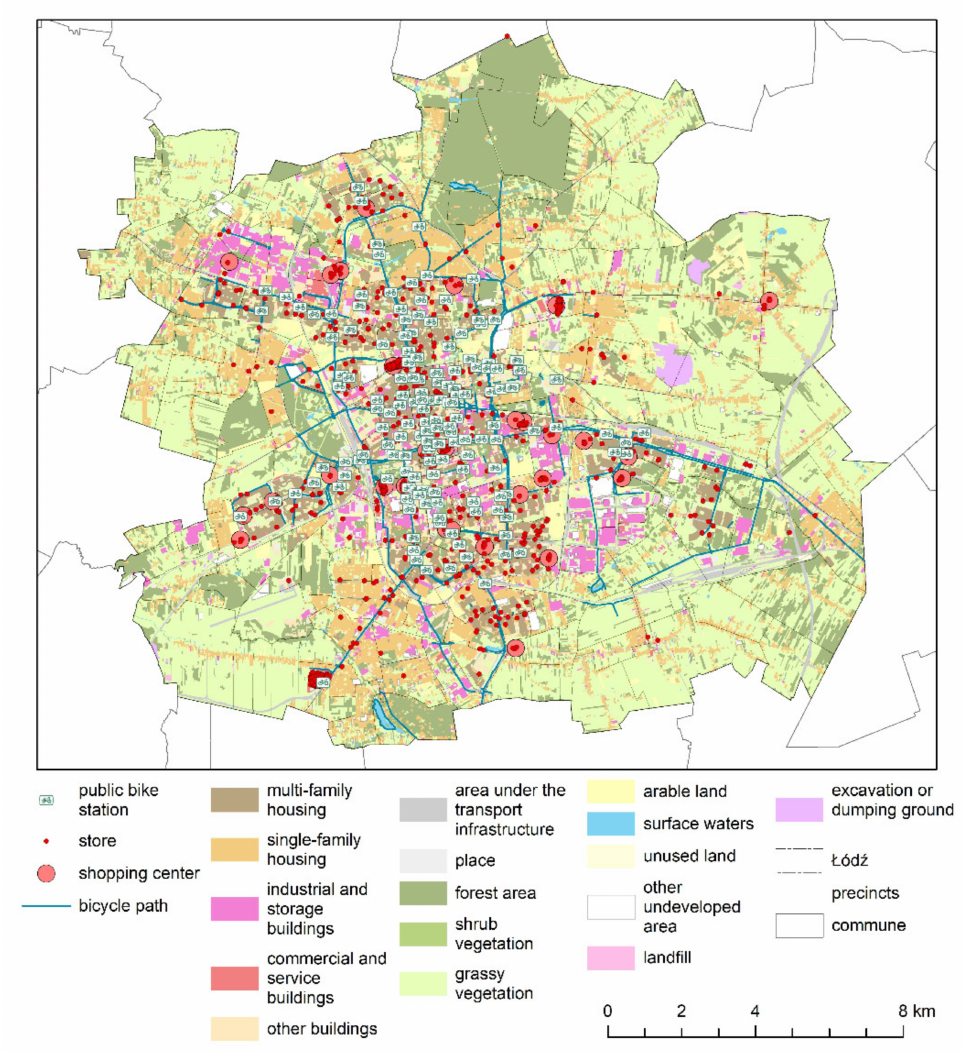
Figure 2. Location of bike docking stations and cycle paths against the network of retail facilities and spatial differentiation of forms of land cover in Ł ó d´z. Source: own elaboration based on data from the Ł ó d´z City Hall, OpenStreetMap, and the Database of Topographic